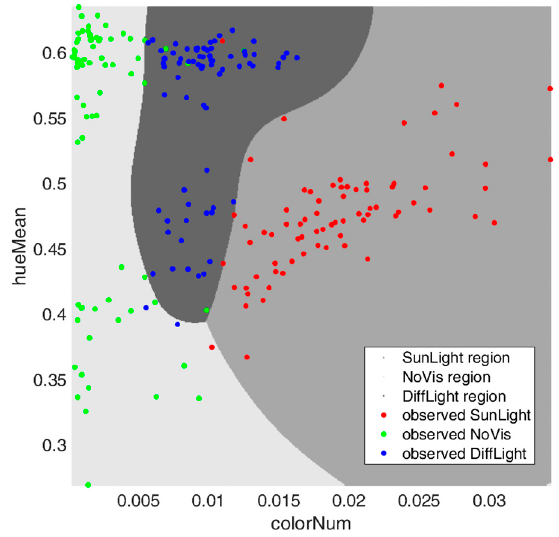
Figure 8. Image classification of PPCX_1 images using the two principal features hueMean and colorNum . The regions delimit the areas where new elements within are classified as belonging to the corresponding class.